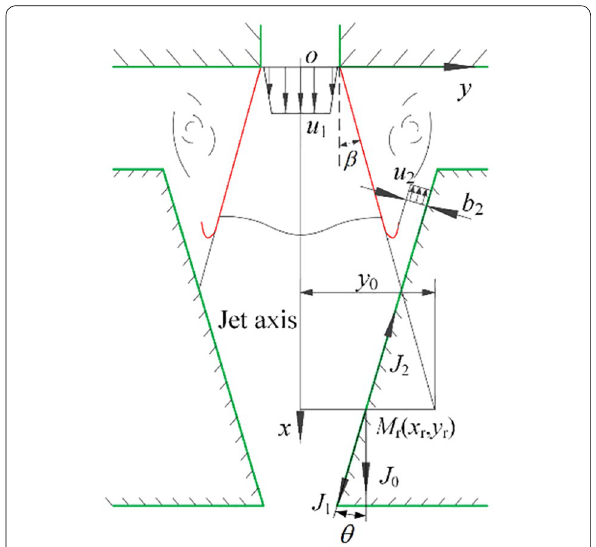
Figure 5 First jet’s impact and stagnation point